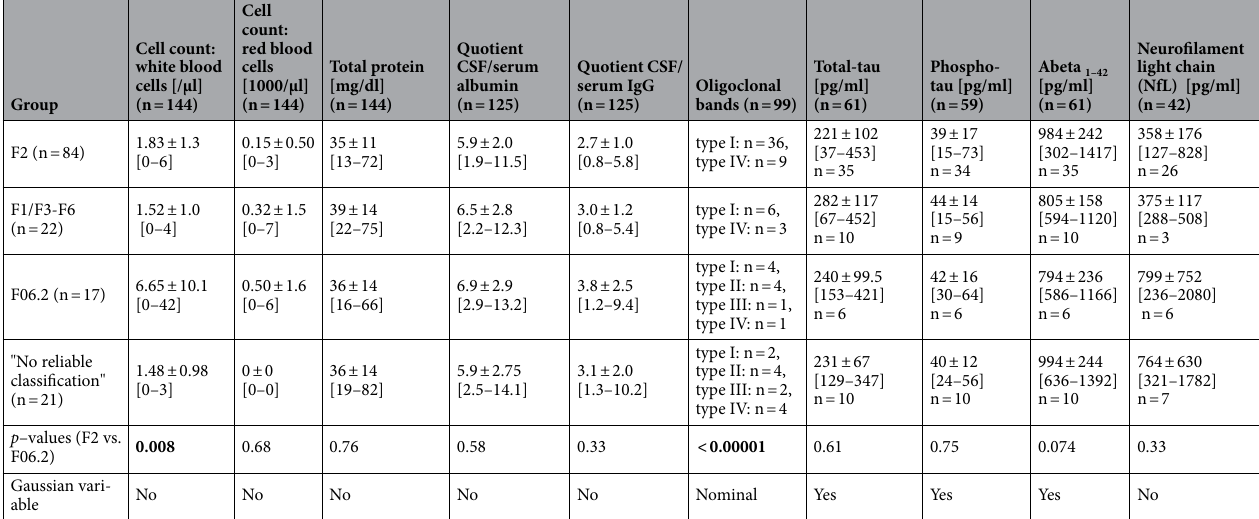
Table 2. Cerebrospinal fluid (CSF) findings. All values are reported as mean ± standard deviation, range [minimum–maximum]. All variables were non-Gaussian variables and therefore tested using the Mann– Whitney-U-Test; two-sided significance level was used. OCB group differences were analyzed using Pearson’s chi-square test. This data analysis was exploratory, no correction for multiple testing was applied. Bold items are below an alpha of 5%. Abbreviations: CSF: cerebrospinal fluid, OCBs: oligoclonal